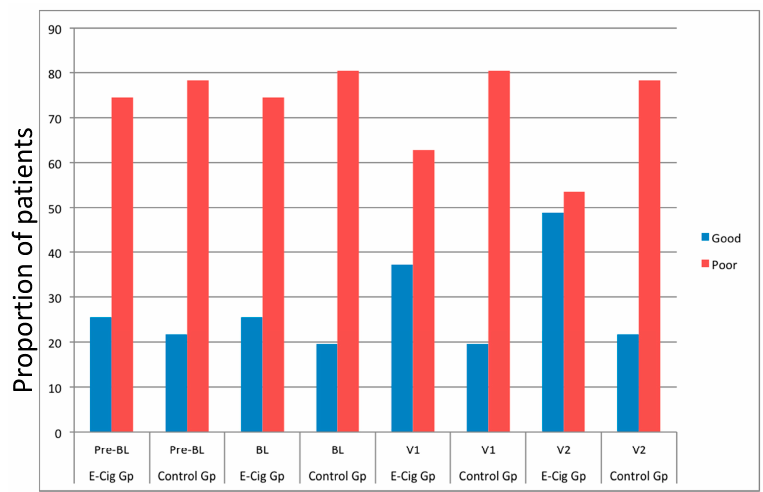
Figure 3. Proportion of good (blue bar) and poor (red bar) patients’ blood pressure control at baseline, at visit 1 (6 ± 1 months), and visit 2 (12 ± 2 months) separately for electronic cigarettes users and